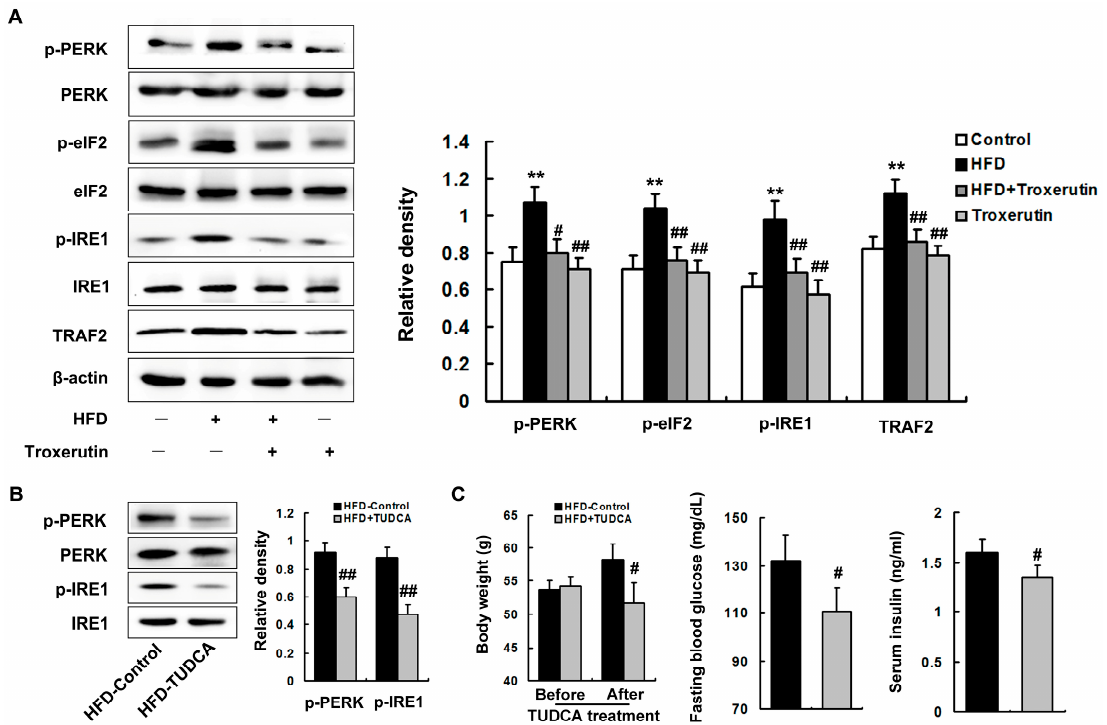
Figure 5. Troxerutin abates ER stress in HFD-treated mouse livers. ( A ) Immunoblotting and densitometry of ER stress-relative proteins in mouse livers ( n = 3); ( B ) Immunoblotting and densitometry of ER stress markers in mouse livers ( n = 3); ( C ) Total body weight, serum insulin, and fasting blood glucose in mouse livers ( n = 5); All of the values are expressed as the mean ± SD. ** p < 0.01 vs. the control group; # p < 0.05, ## p < 0.01 vs. the HFD group.